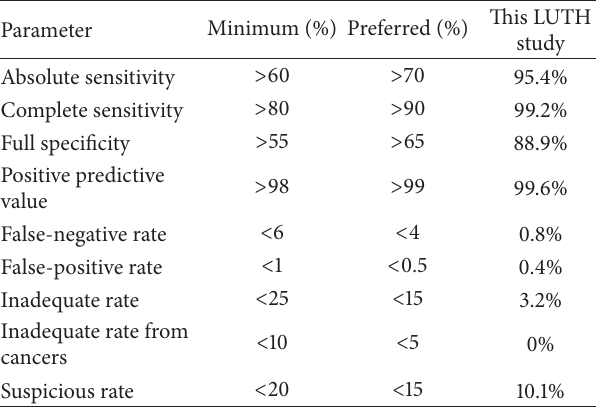
Table 2: Comparison of results with UK NHSBSP thresholds of